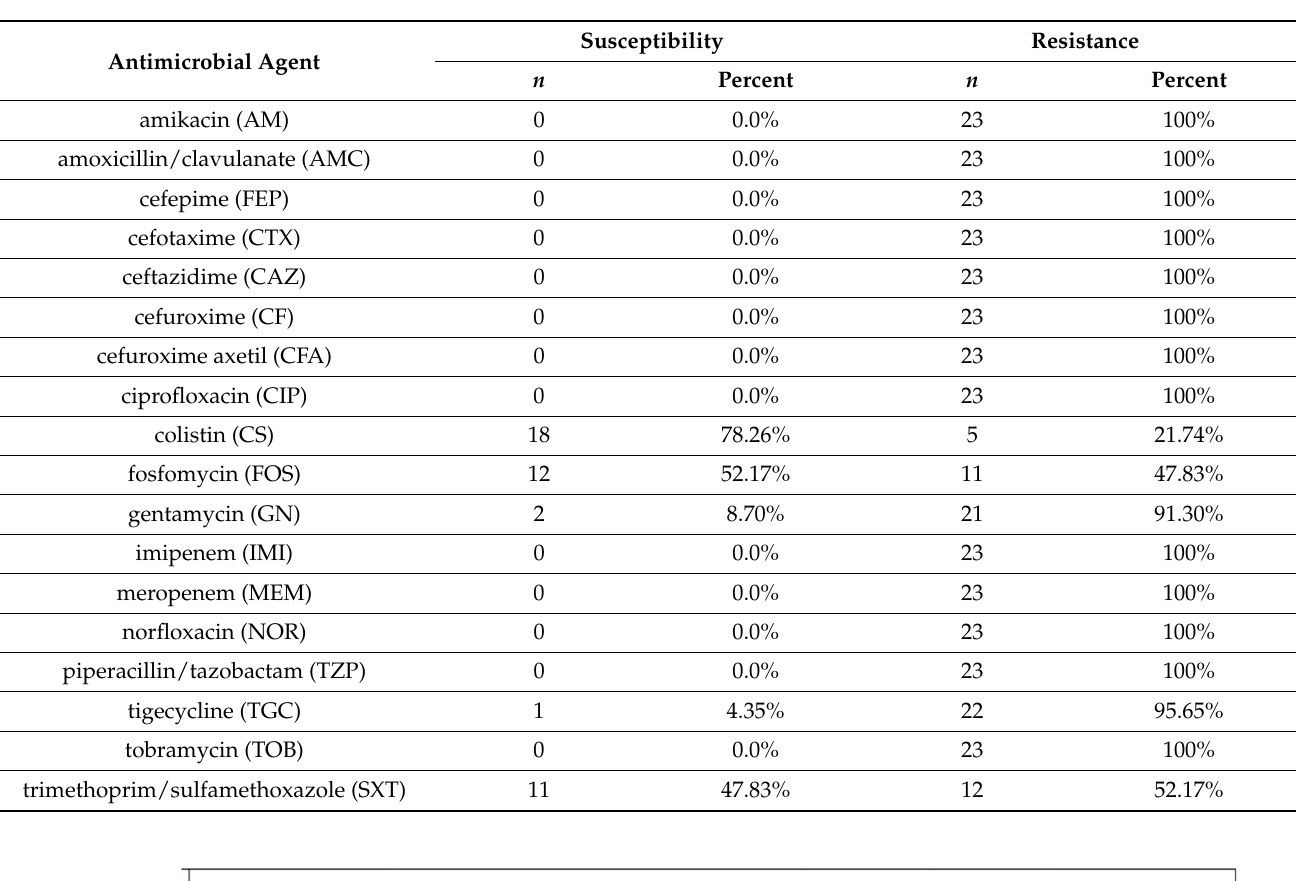
Table 2. Antimicrobial susceptibility and resistance of K. pneumoniae NDM strains isolated from urine samples of all 23 patients.